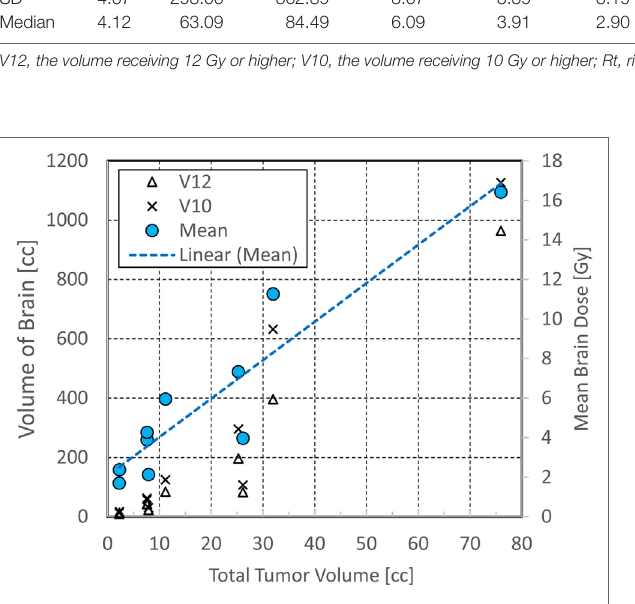
FigUre 3 | Correlation of the total tumor volume with the mean, V10 and V12 of whole brain. Correlation coefficient was calculated for the mean brain